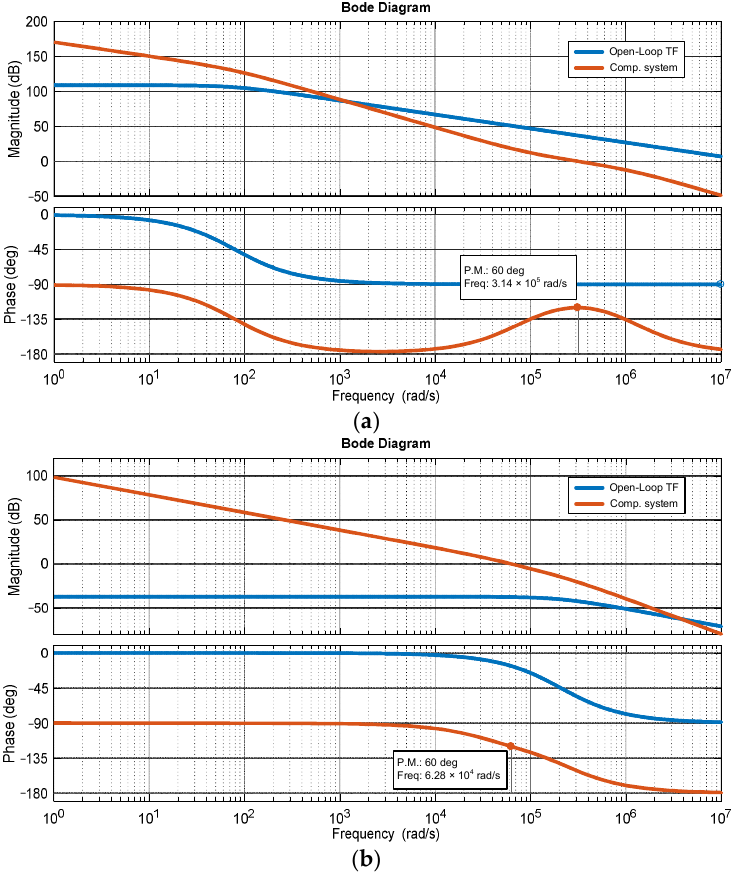
Figure 11. Bode plots of the linear controllers. ( a ) Current control loop, ( b ) voltage control